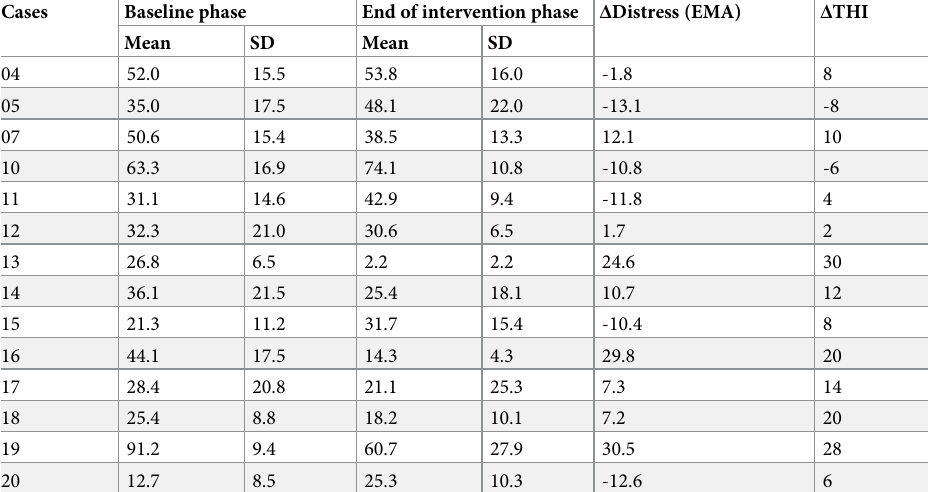
Table 3. Improvement in tinnitus distress from baseline to end of intervention phase. Cases